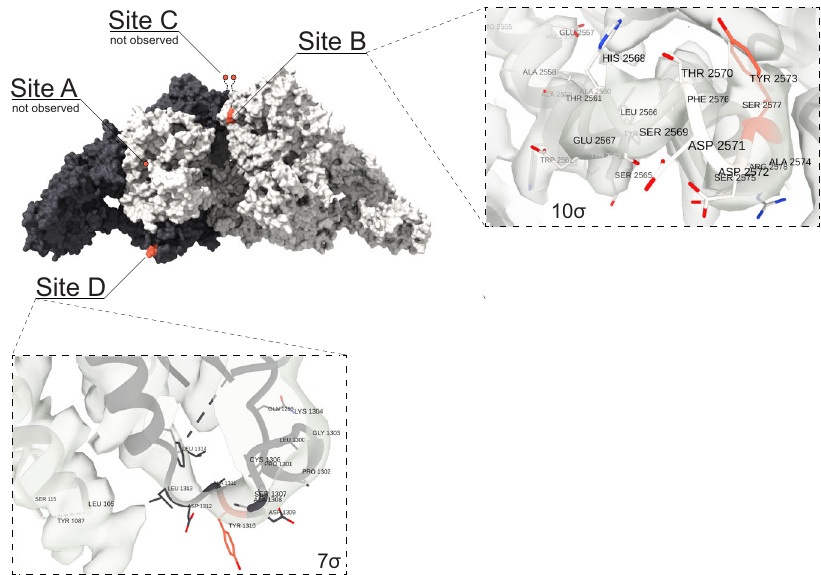
Fig. 6 Location of hormonogenic sites in hTG structure. (Top left) hTG surface representation with one monomer in charcoal and one monomer in white. Acceptor tyrosine residues, Y2573 and Y1310 in ~15 Å proximity 18 at each canonical site (A to D) are marked in red, for which at Y2573, additionally MIT and DIT were detected in MS experiments. The insets show sites B and D in detail with the respective cryo-EM density and its corresponding threshold level to aid con fi dence